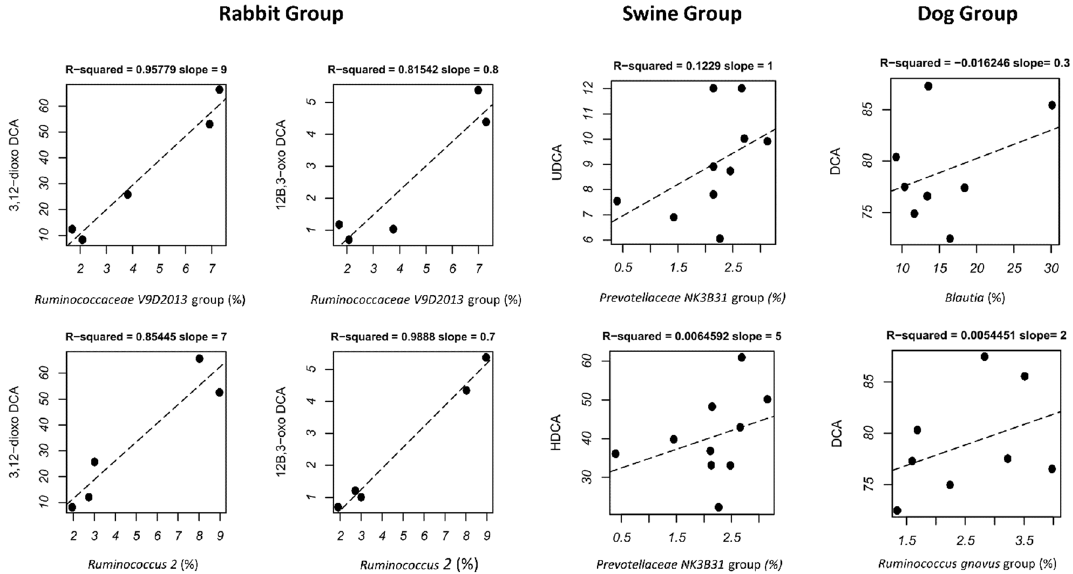
Figure 7. Linear regression plots showing positive associations between the relative abundances of gut genera and BAs in different farming